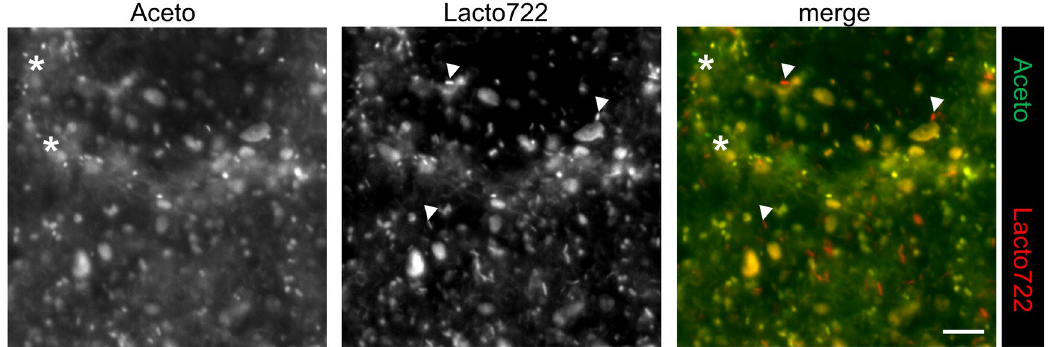
Fig 3. Fluorescence in situ hybridization of adult Drosophila feces. FISH was performed with PFA-fixed adult Drosophila feces using the genera-specific probes Aceto (green) and Lacto722 (red) (4 μ M/probe) and 40% formamide for three hours at 46˚C. Prior to hybridization, feces samples were treated with 10 mg/ml lysozyme for 15 minutes at 37˚C. Detected Acetobacter cells are marked with asterisks and Lactobacillus cells are indicated by arrowheads. The figure shows representative examples from at least three separate experiments. Scalebar represents 5 μ